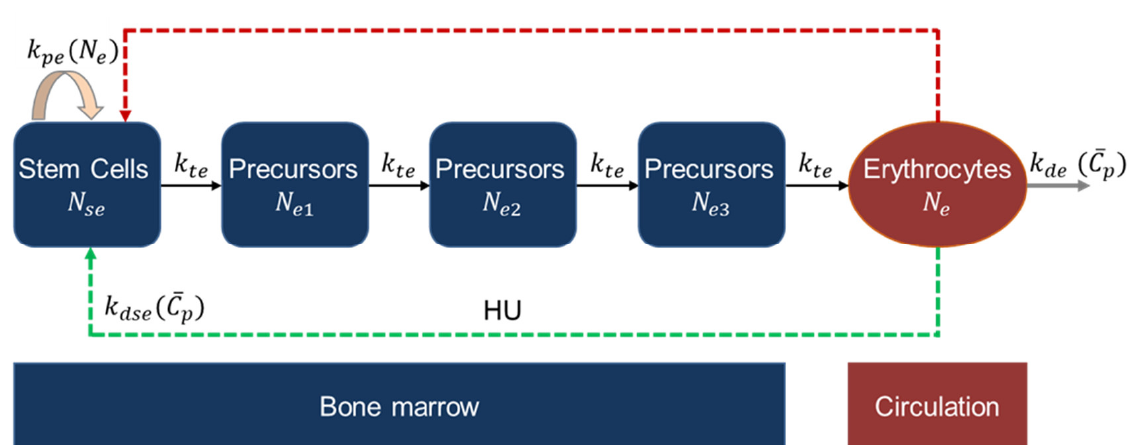
Figure 5. Schematic of erythropoiesis model. The dashed red arrow represents negative feedback regulation from the circulating cells; the dashed green arrow represents HU-related effect.